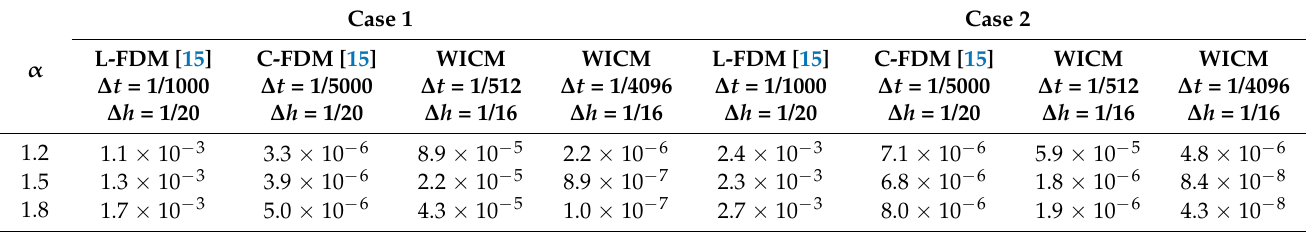
Table 5. Error norms of numerical solutions with similar spatial grid for Example 4 with different α